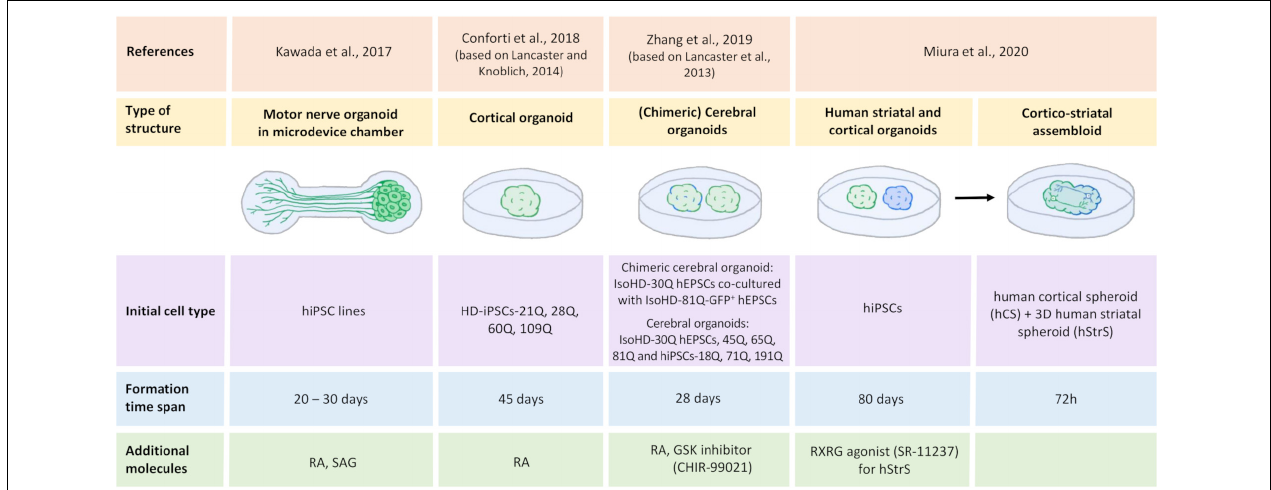
FIGURE 4 | Generation of human iPSC-derived three-dimensional brain structures modeling HD. All illustrated HD organoids, including two region-specific brain organoids that consist of the three-dimensional (3D) human striatal spheroid (hStrS) and human cortical spheroid (hCS) that were used to create the assembloid by Miura et al. (2020), originated from induced pluripotent stem cells (iPSCs). Cortical organoids (Conforti et al., 2018; Zhang et al., 2019) and the chimeric organoids (Zhang et al., 2019) represent 3D cell models of Huntington’s disease. Motor nerve organoids extended axons as a result of their culture in the special chamber with microchannels (Kawada et al., 2017). The organoid formation time differs depending on the protocol. Neural differentiation inducers were used in the organoids formation process: retinoic acid (RA) (Kawada et al., 2017; Conforti et al., 2018; Zhang et al., 2019), retinoid X receptor γ (RXRG) agonist, SR-11237 (Miura et al., 2020), glycogen synthase kinase (GSK) inhibitor, CHIR-99021 (Zhang et al., 2019), and sonic hedgehog signaling agonist (SAG) (Kawada et al.,